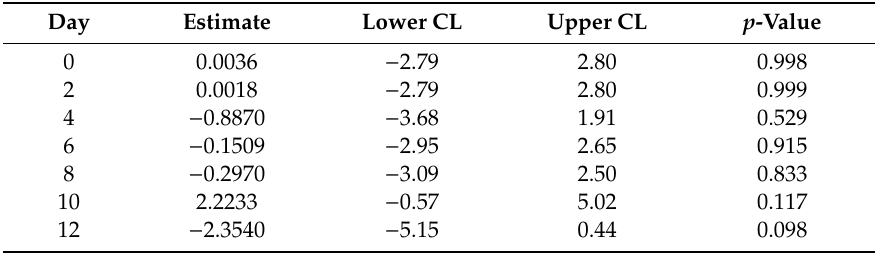
Table 1. Di ff erence between 0-dose and low-dose groups in least square means of PAX6 RNA expression according to day.